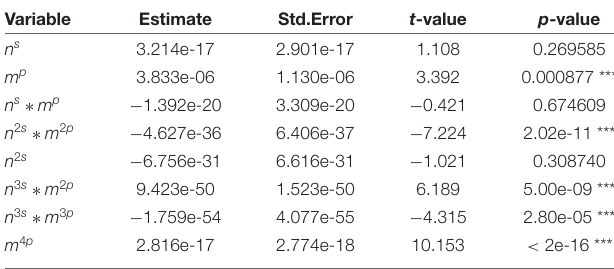
TABLE 4 | Summary statistics for selected variables in finite sample size between 71 and 90.